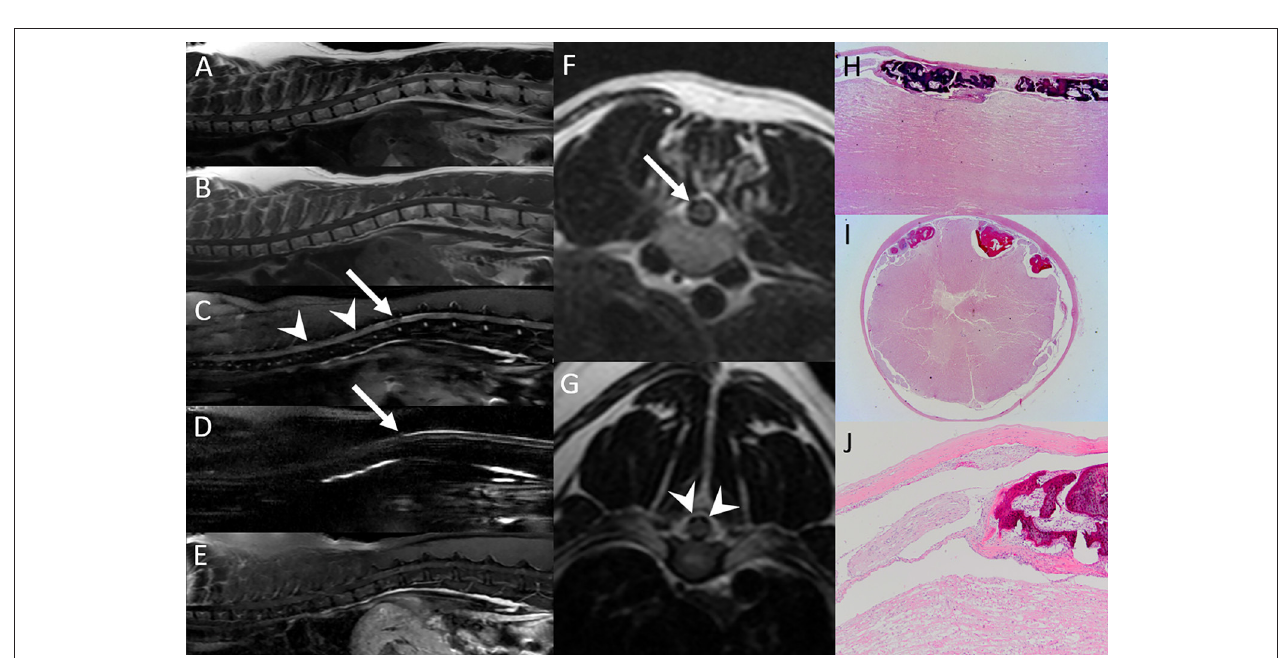
FIGURE 12 | Subdural and subarachnoid ossification resulting in spinal cord compression in a serval. Sagittal T2-W (A) ,T1-W (B) , STIR (C) , HASTE (D) and post contrast FatSat (E) and transverse T2-W images at T11-12 (F) and T7-8 (G) . Sagittal (H) and transverse (I,J) pathology images. (A–G) Multifocally within the vertebral canal and bordering the spinal cord there are hypointense foci (arrowheads), with the impression of an intradural-extramedullary mass lesion at T11-12 (arrow). Best seen on the HASTE sequence (D) , there is extensive attenuation of the subarachnoid space throughout the thoracic spine. There is no evidence of abnormal contrast enhancement (E) . Differential diagnoses included (granulomatous) meningitis, meningeal neoplasia and/or meningeal adhesions. (H–J) Autopsy was performed and yielded a diagnosis of extensive subdural and subarachnoid ossification with spinal cord